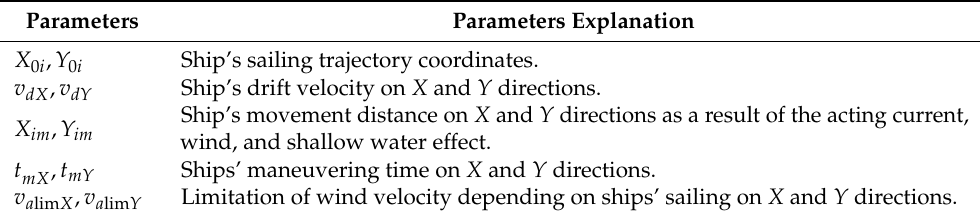
Table 1. Main parameters and variables used in the